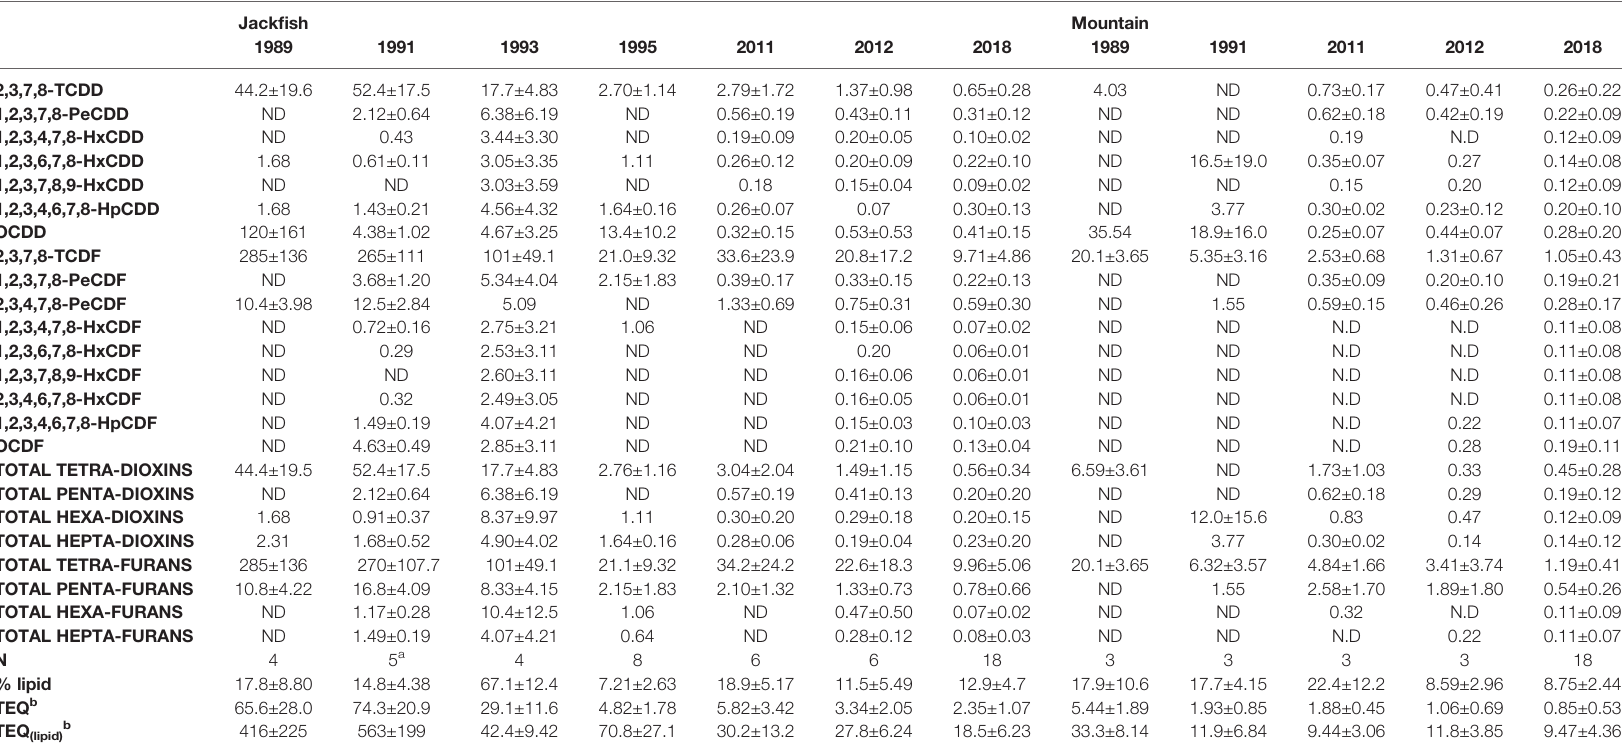
TABLE 7 | PCDD/F concentrations (pg ∙ g − 1 , mean ± SD) with wet weight (pg ∙ g − 1 wet wt., mean ± SD) and lipid normalized (pg ∙ g − 1 lipid, mean ± SD) in liver tissue of male white sucker collected from Jack fi sh Bay and Mountain Bay during the